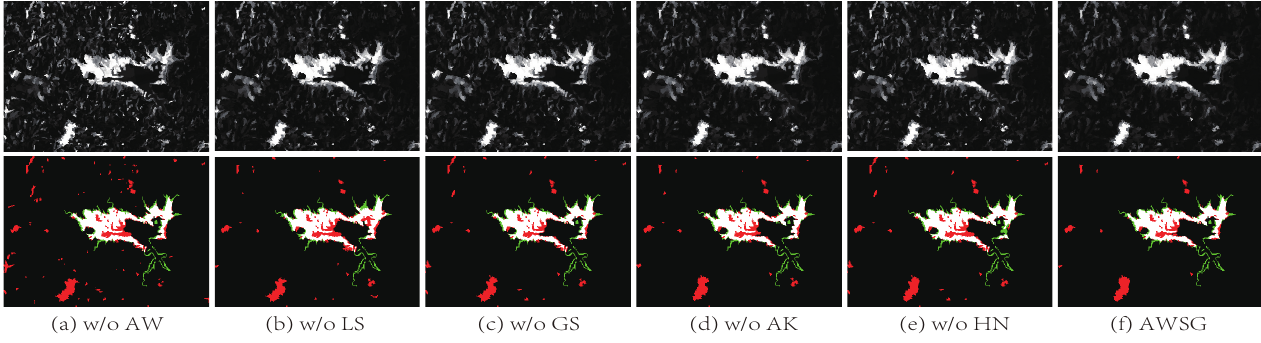
Figure 5. Ablation study of AWSG. From top to bottom, they correspond to the DI and CM generated by different methods on the Dataset #1. From left to right are the results generated by: ( a ) AWSG without auto-weighted strategy; ( b ) AWSG without local structure information; ( c ) AWSG without global structure information; ( d ) AWSG without adaptive k -selection; ( e ) AWSG without high-order neighbor information; ( f ) the original